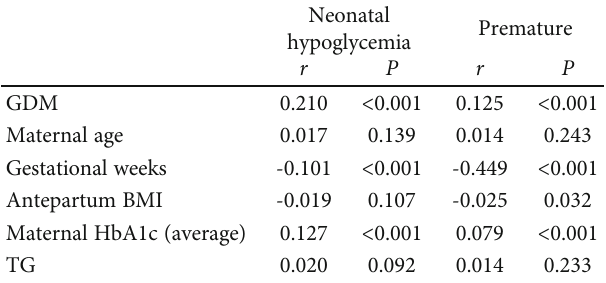
Table 4: Correlations between neonatal outcomes and maternal